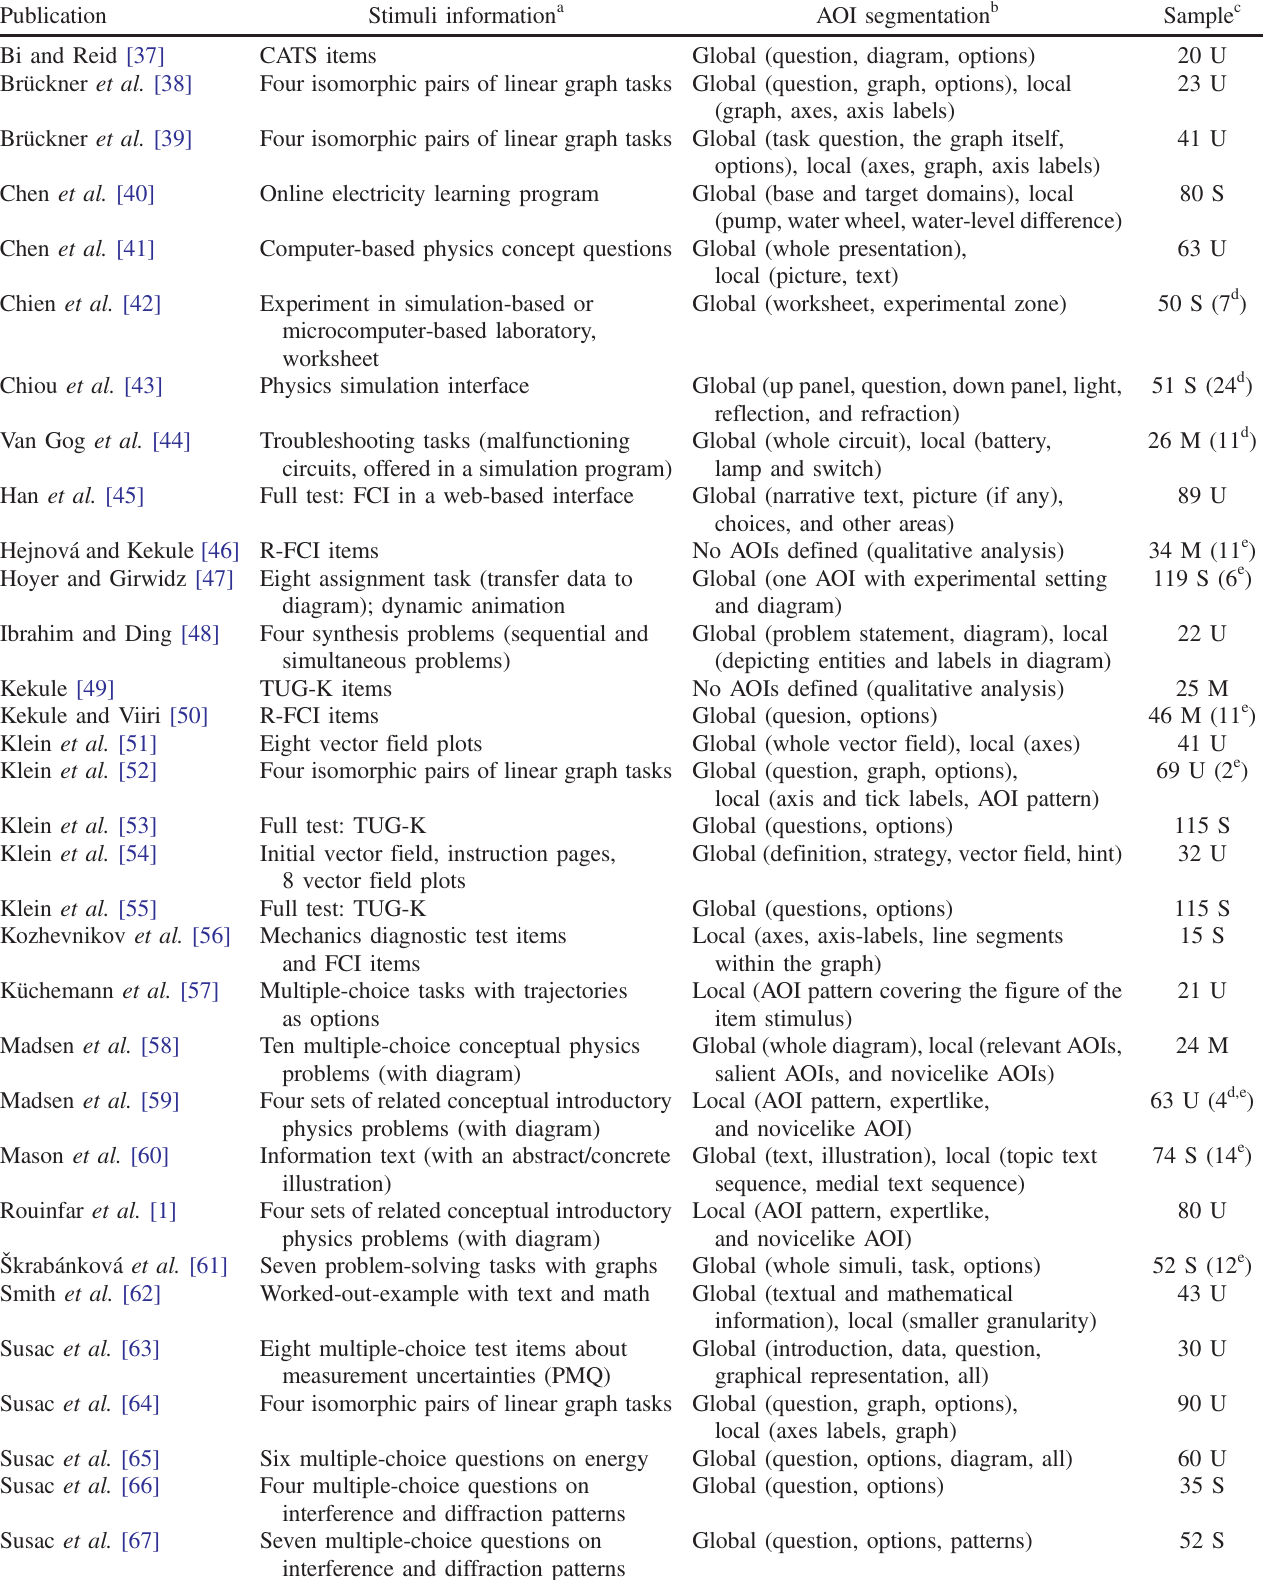
TABLE VIII. Stimuli used in the studies, areas of interest, and sample: